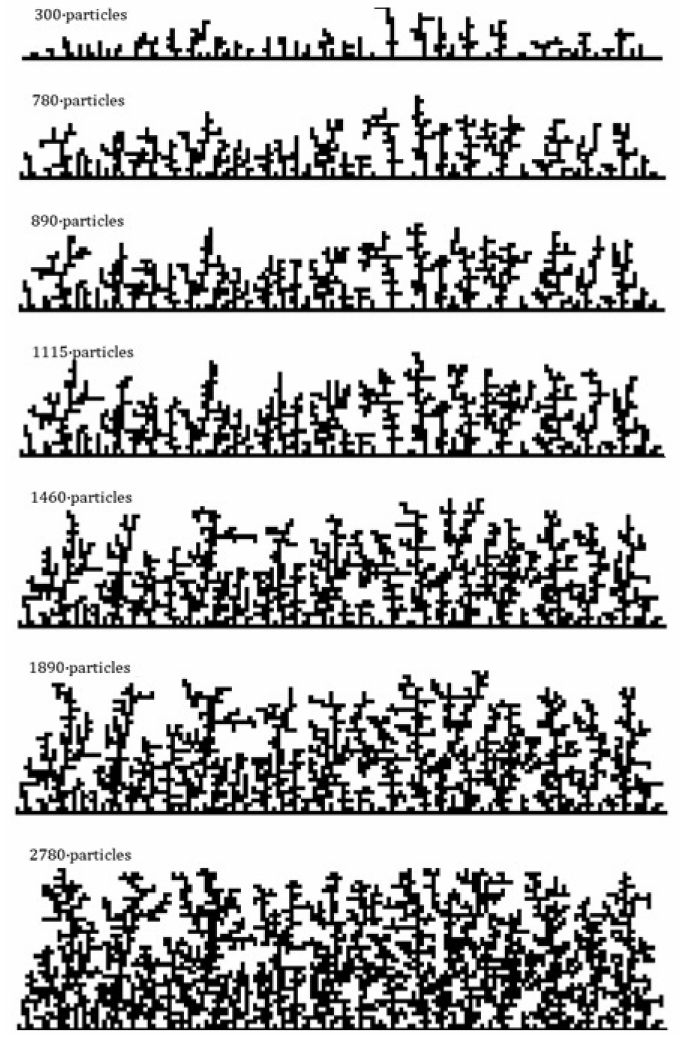
Figure 11. Sample of a porous medium constructed using the diffusion-limited aggregation tech- nique